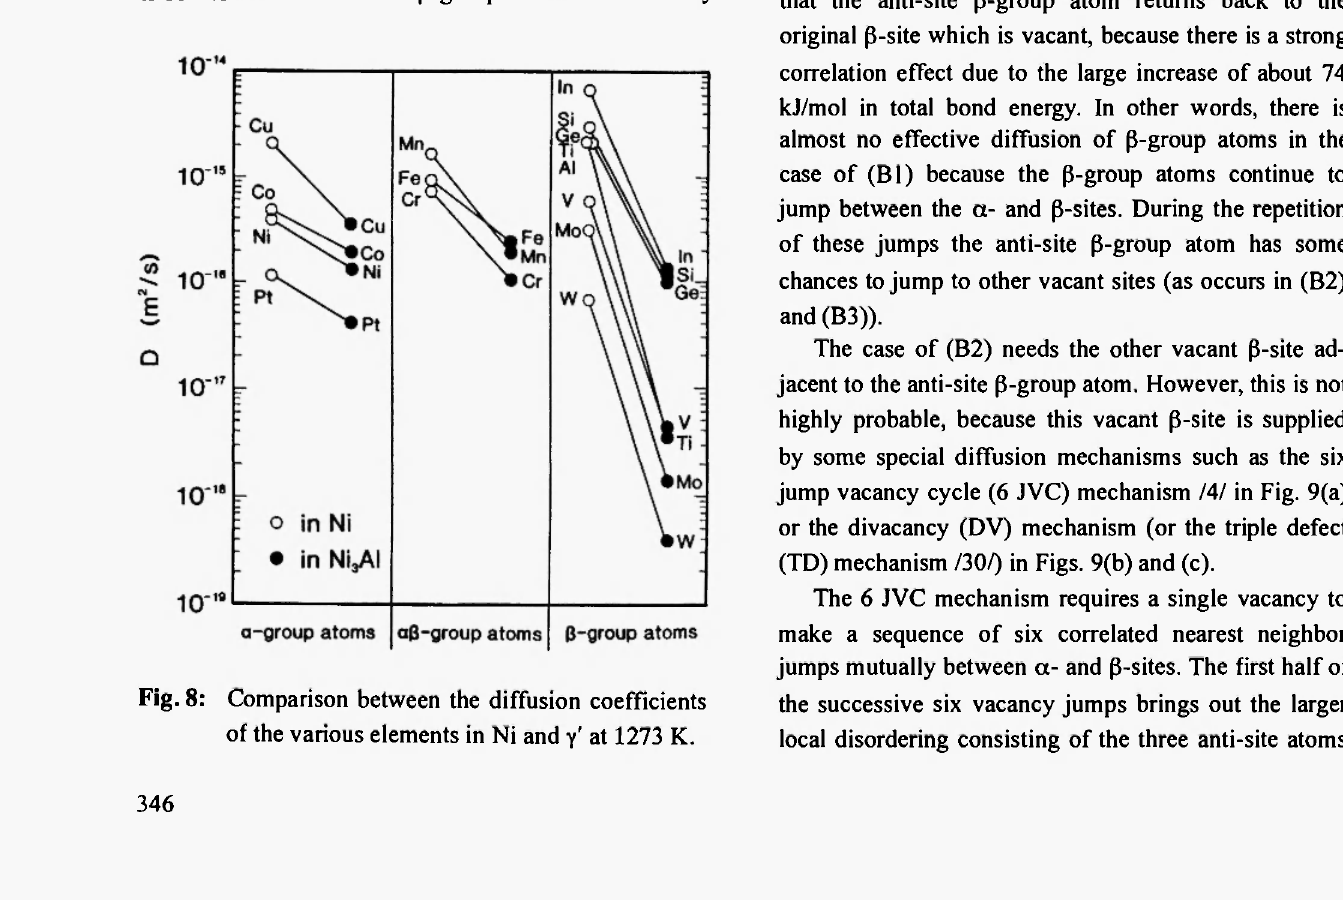
Fig. 8: Comparison between the diffusion coefficients of the various elements in Ni and γ' at 1273